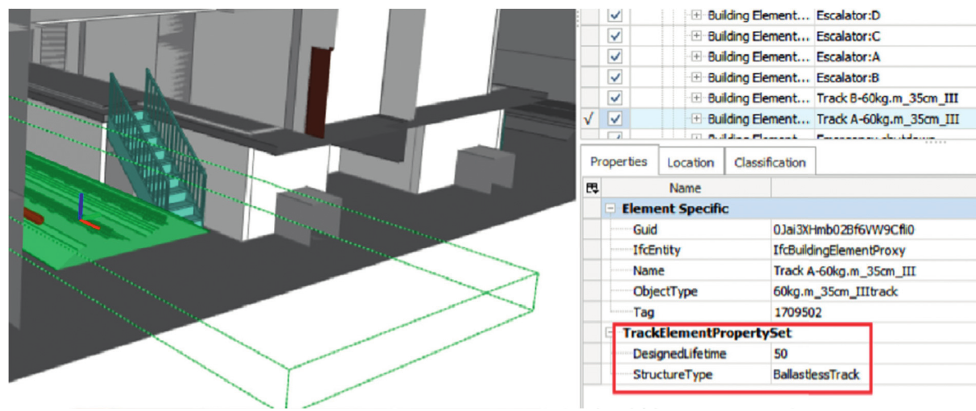
(a) Figure 20: Continued.